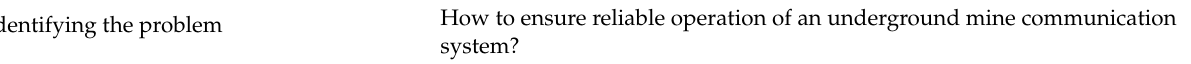
Table 2. Research